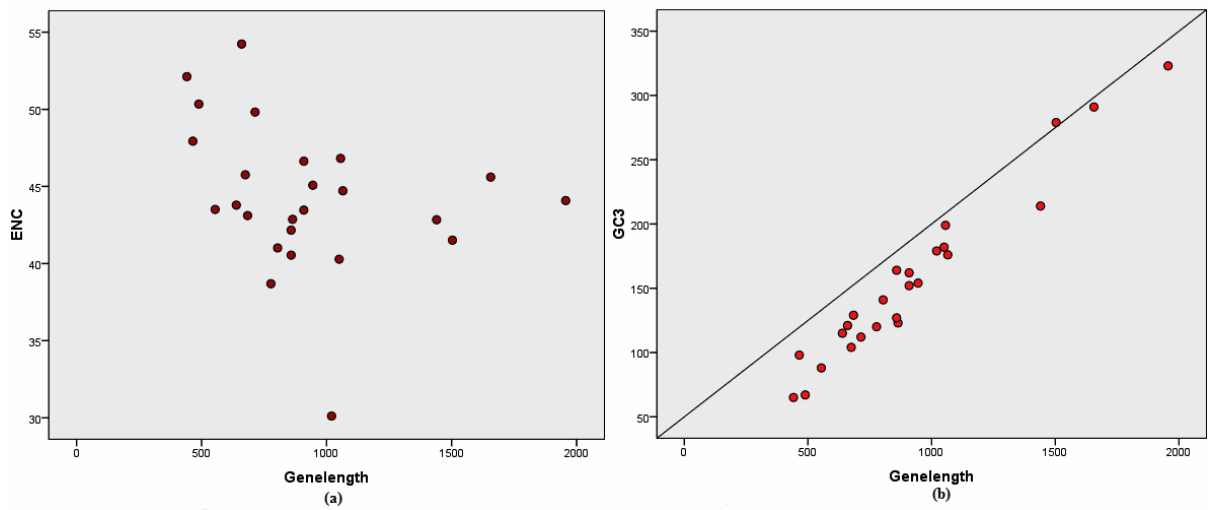
Fig. 4. Correlation between (a) ENC values and gene length (bp); (b) GC3 values and gene length